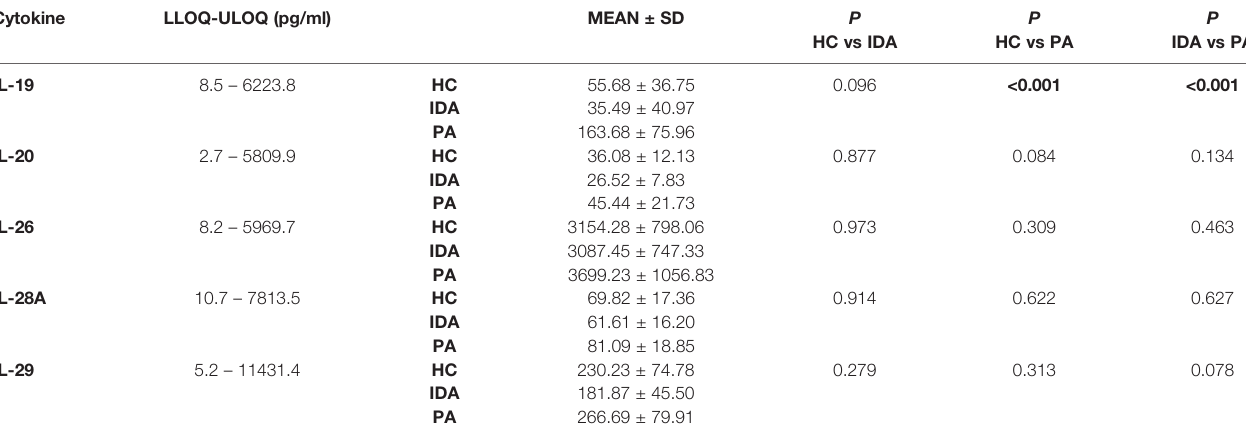
TABLE 3 | Luminex assay results for IL-19, IL-20, IL-26, IL-28A and IL-29 levels in sera of HC, Healthy controls; IDA, Iron de fi ciency anemia patients; PA, Pernicious anemia patients. Cytokine LLOQ-ULOQ (pg/ml)